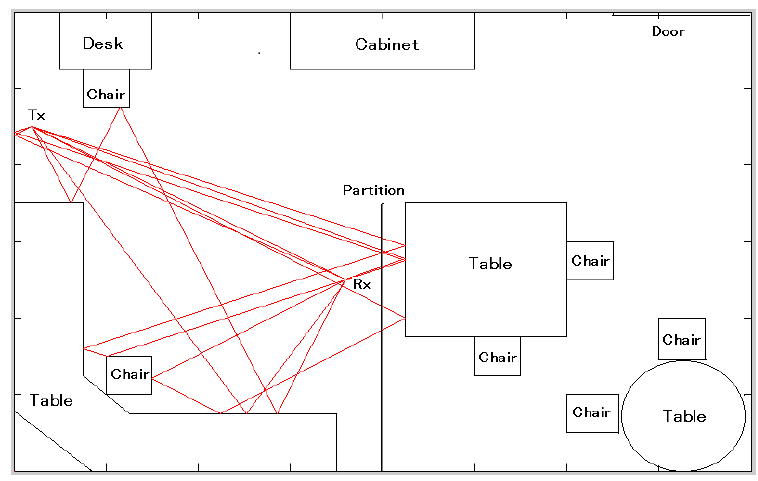
Figure 1. Ray tracing for indoor propagation